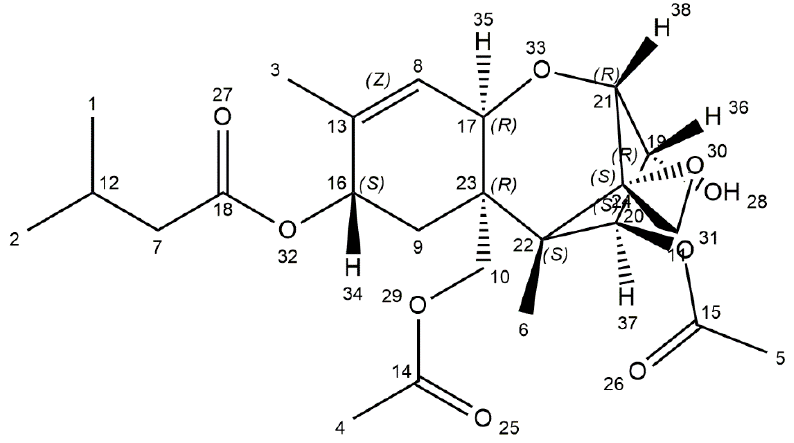
Figure 3. Chemical structure of toxin T-2 (structure generated from InChI code available on https://pubchem.ncbi.nlm.nih.gov/) (accessed on 16 August 2020).